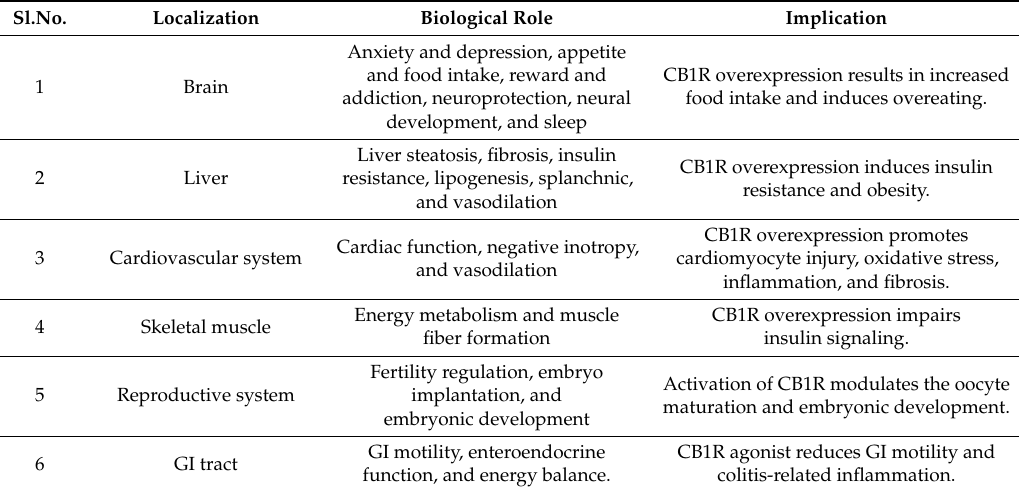
Table 1. The distribution and functions of CB1R in the human